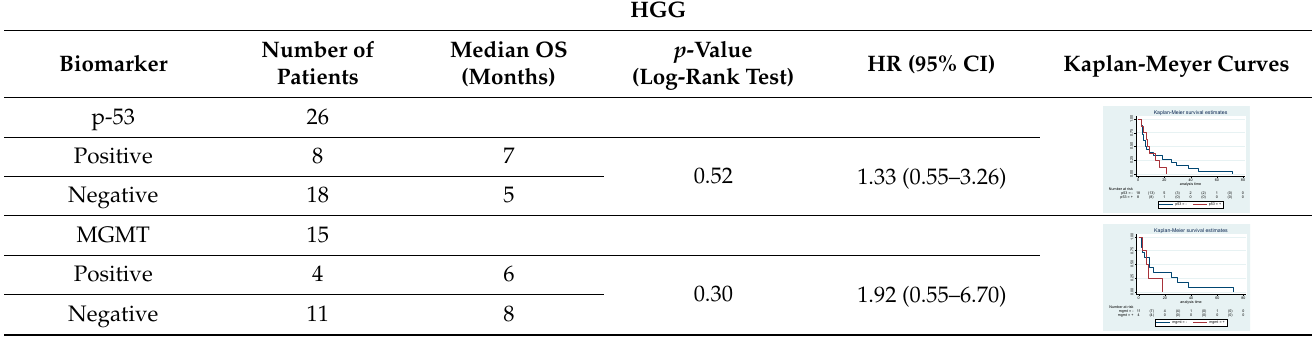
Table 3. Molecular characterization of HGG with survival estimates. SG and BG samples appear as a unique cohort to reduce the impact that different treatments would have manifested on the results